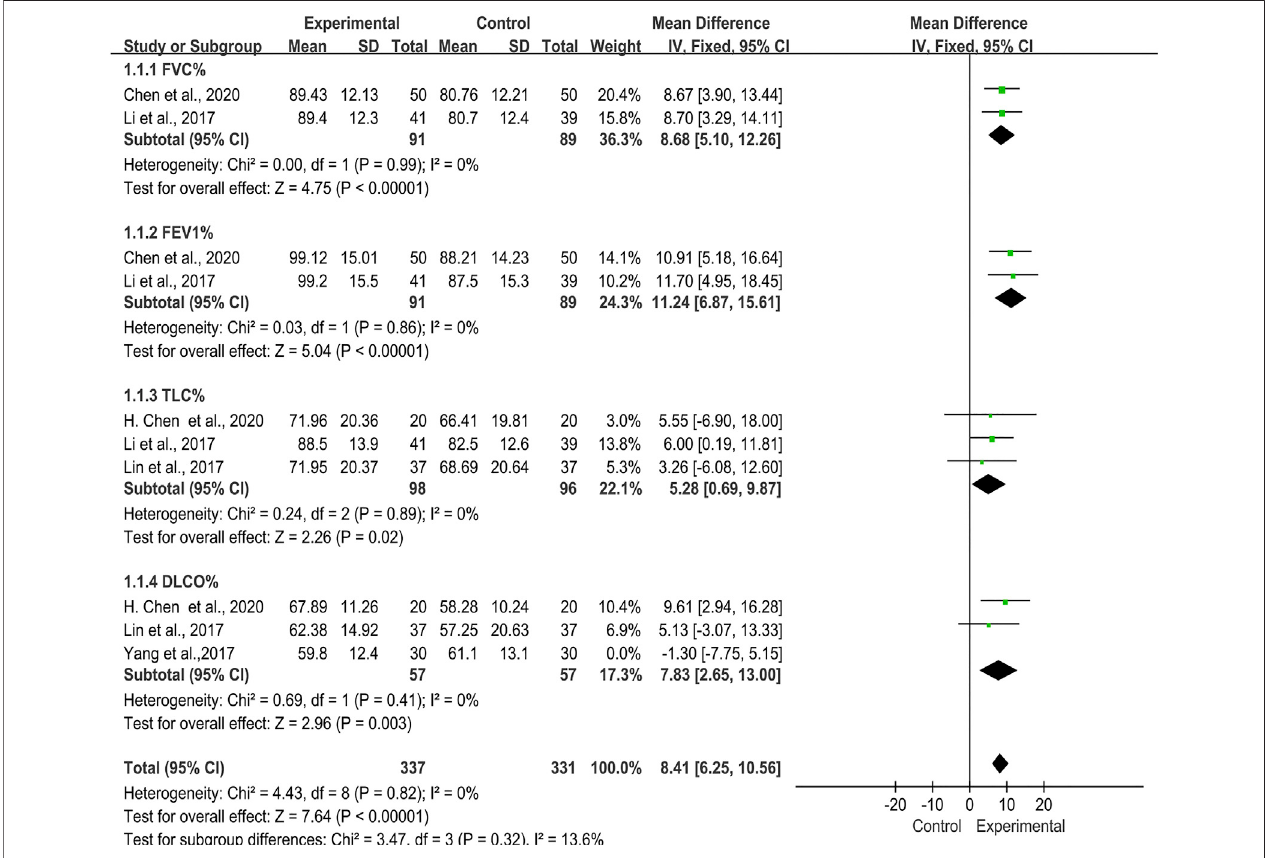
FIGURE 9 | Forest plot of sensitivity analysis of lung function with TwHF combined with conventional treatment versus pure conventional treatment.